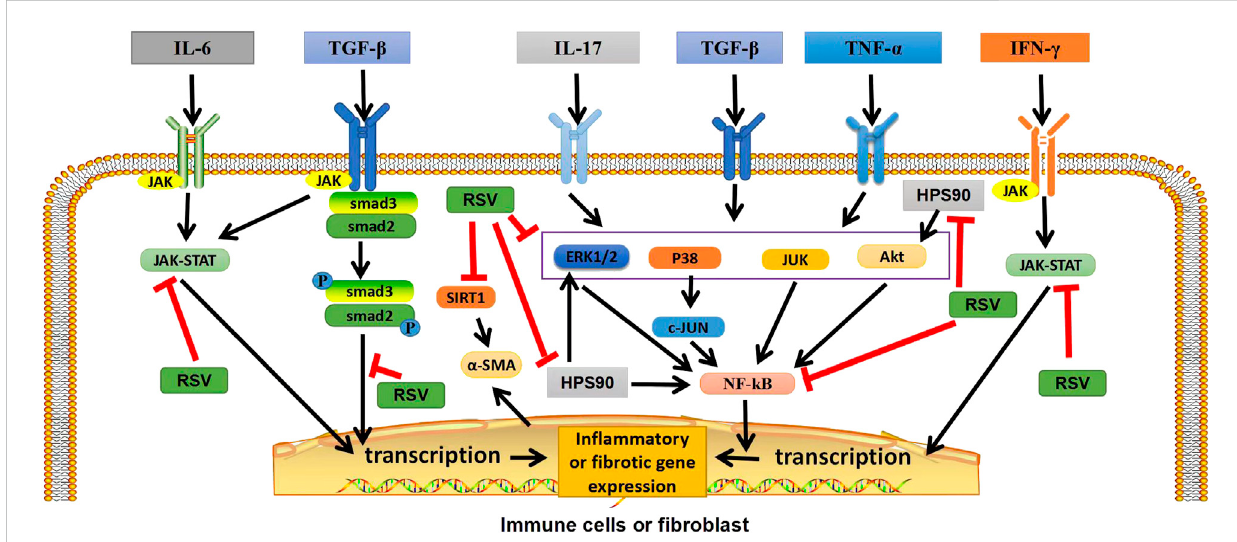
FIGURE 1 Graphical abstract: Potential targets of RSV in ILD. In immune cells or fi broblasts, RSV exerts anti-in fl ammatory and anti fi brotic effects by inhibiting TGF- β /Smad2/3/4,NF- κ B,andJAK/STATpathways,aswellasbyregulatingheatshockprotein90,inhibitingAkt,ERK1/2andNF- κ Bpathways.Inaddition, RSV can also inhibit SIRT1, reduce α -ASM activation, and play an anti fi brotic role. TGF- β , transforming growth factor β ; IFN- γ , interferon- γ ; TNF- α , tumor necrosis factor; P, phosphate; JAK, janus tyrosine kinase; STAT, signal transducers and activators of transcription; ERK1/2,extracellular signal- regulated protein kinases; AKT, serine-threonine kinase; NF- κ B, nuclear factor-kappa B; SIRT1, sirtuin1; α -SMA, α -smooth muscle actin. “ ê ” indicates activation, and “— ׀ ” indicates